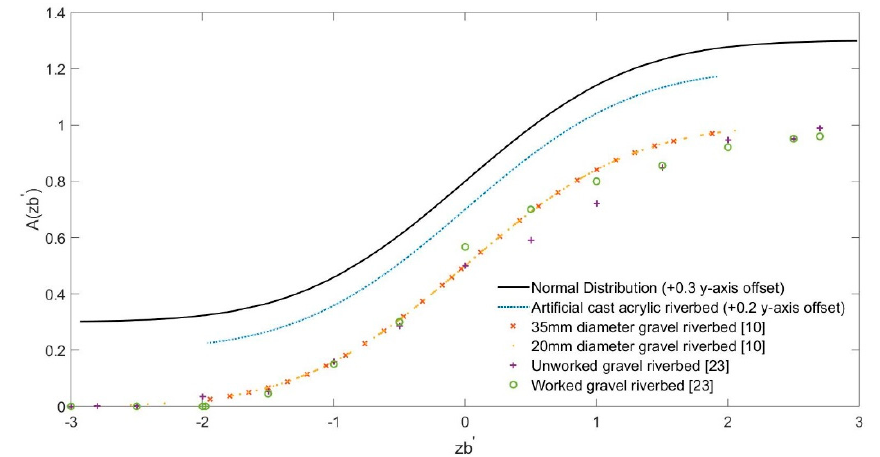
Figure 7. Cumulative probability distribution of surface elevations for natural and artificial gravel riverbeds of various studies.